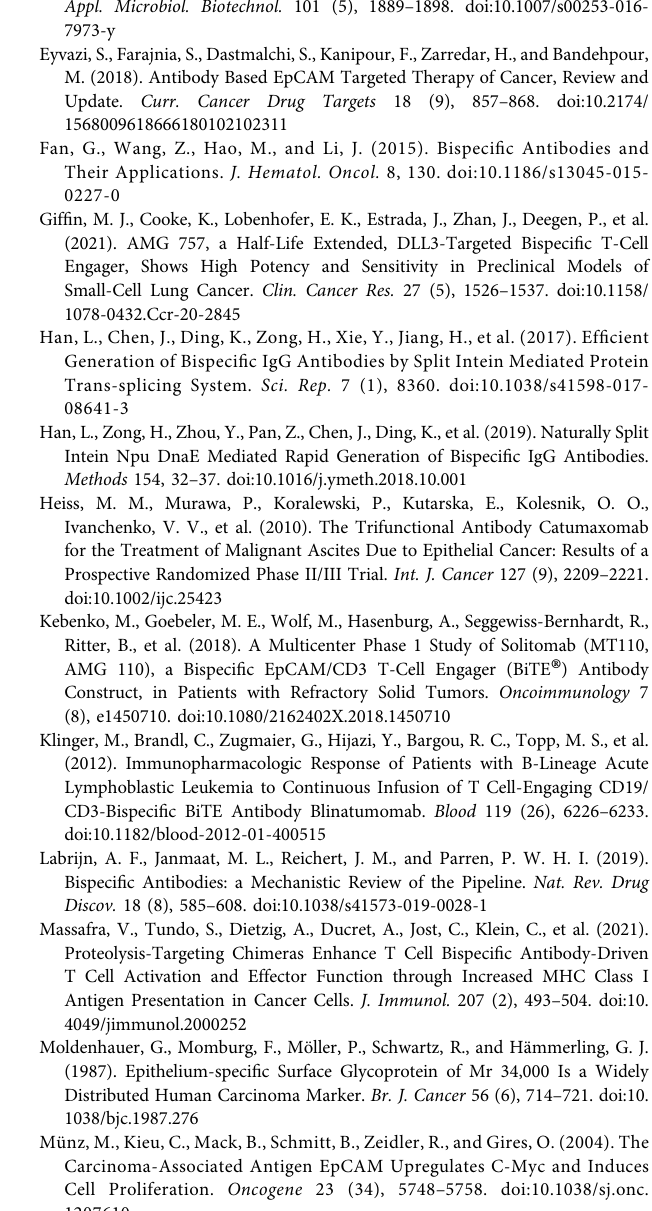
Supplementary Figure S2 | Subtracteddata process ofCD3×EpCAM BsAbin the binding test to EpCAM. Supplementary Figure S3 | Invitro cytotoxicityassayofEpCAMnegativecellsand optimization. (A) In vitro cytotoxicity assay in the presence of T cells and target cells. (B) In vitro cytotoxicity assay of CD3×EpCAM BsAb to SW480 cells at a concentration of 1.5 mg/ml in different E:T ratio. (C) Expression of EpCAM on Jurkat cells detected by fl ow cytometry. (D) In vitro cytotoxicity assay of CD3×EpCAM BsAb and EpCAM mAb to Jurkat cells detected by LDH release assay. Supplementary Figure S4 | T cell activation maker CD107a analysis detected by fl ow cytometry. (A) The CD107a detection of CD8 + cells to tumor cells by CD3×EpCAM BsAb, EpCAM mAb, and CD3 mAb. (B) The CD107a detection of CD4 + cells to tumor cells by CD3×EpCAM BsAb, EpCAM mAb, and CD3